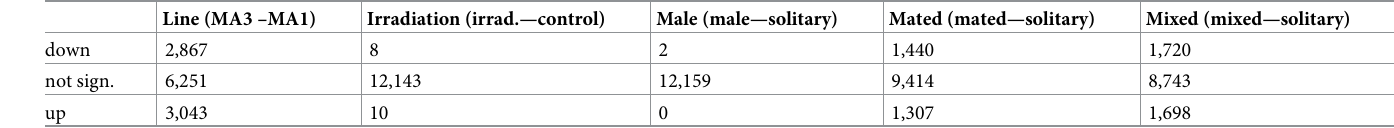
Table 1. Summary of differential gene expression analysis for the contrasts of interest, significance at 5% false discovery rate. Line (MA3 –MA1)